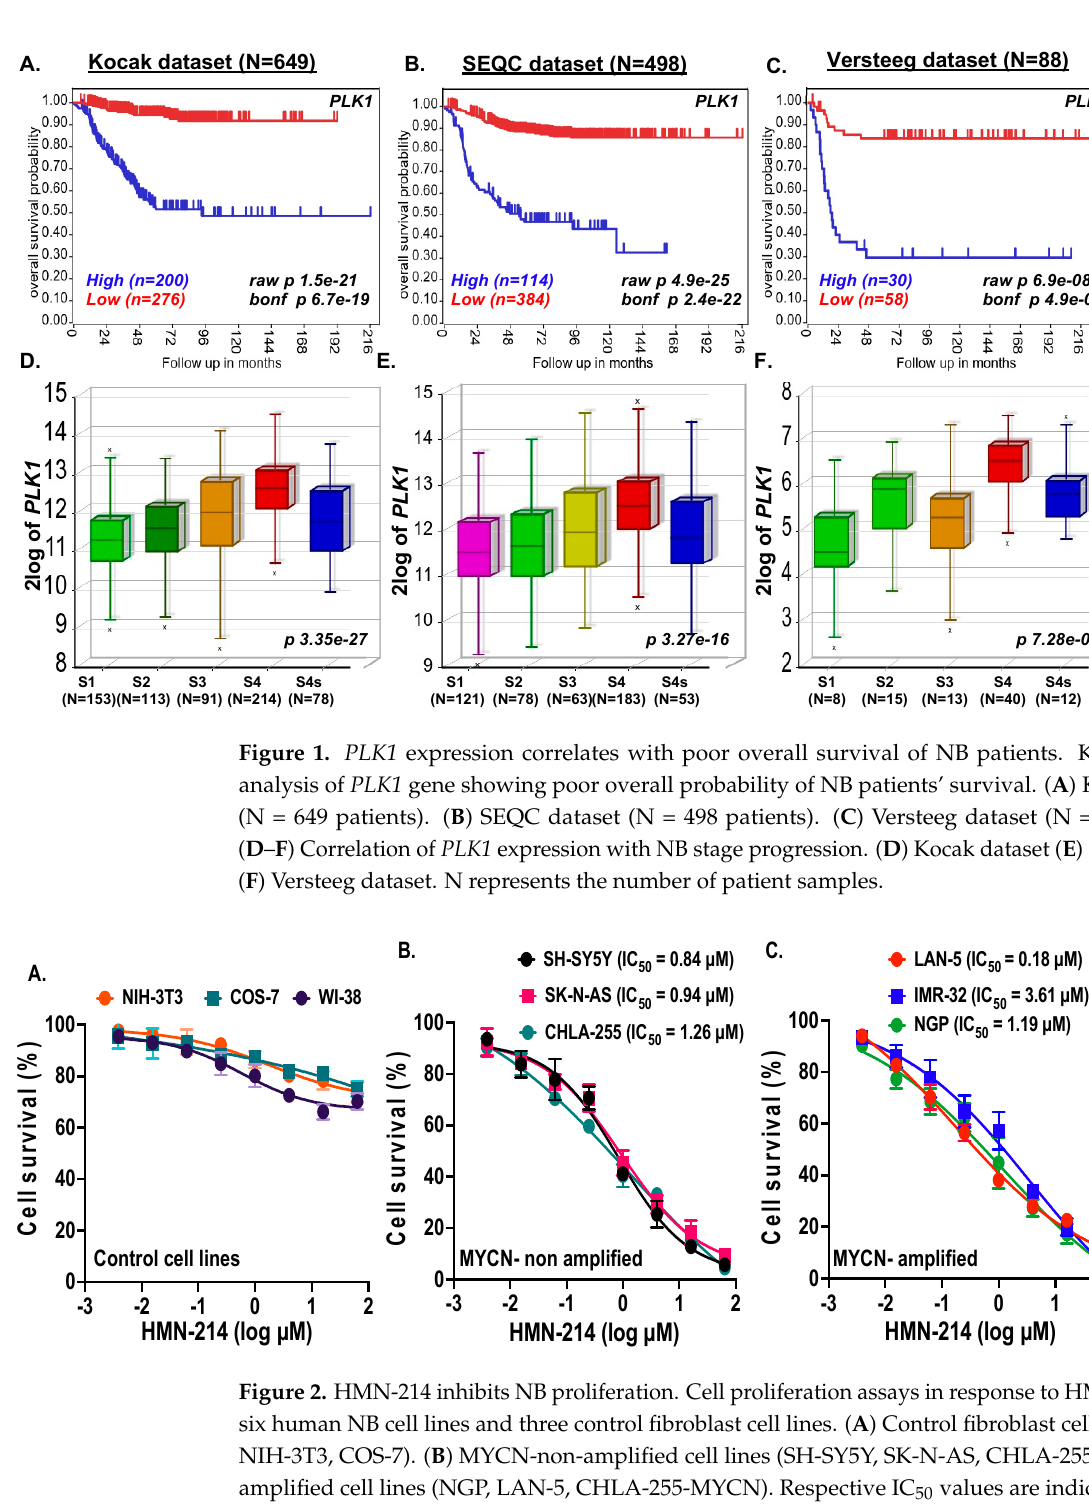
Figure 1. PLK1 expression correlates with poor overall survival of NB patients. Kaplan–Meier anal- ysis of PLK1 gene showing poor overall probability of NB patients’ survival. ( A ) Kocak dataset (N = 649 patients). ( B ) SEQC dataset (N = 498 patients). ( C ) Versteeg dataset (N = 88 patients). ( D – F ) Correlation of PLK1 expression with NB stage progression. ( D ) Kocak dataset ( E ) SEQC dataset ( F ) Versteeg dataset. N represents the number of patient samples.